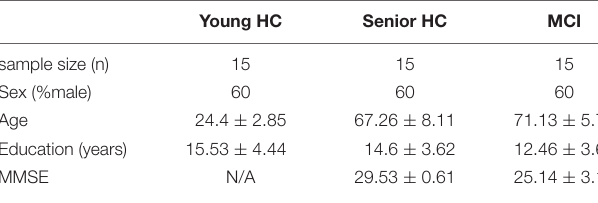
TABLE 1 | Demographic data of MCI, senior HC, and young